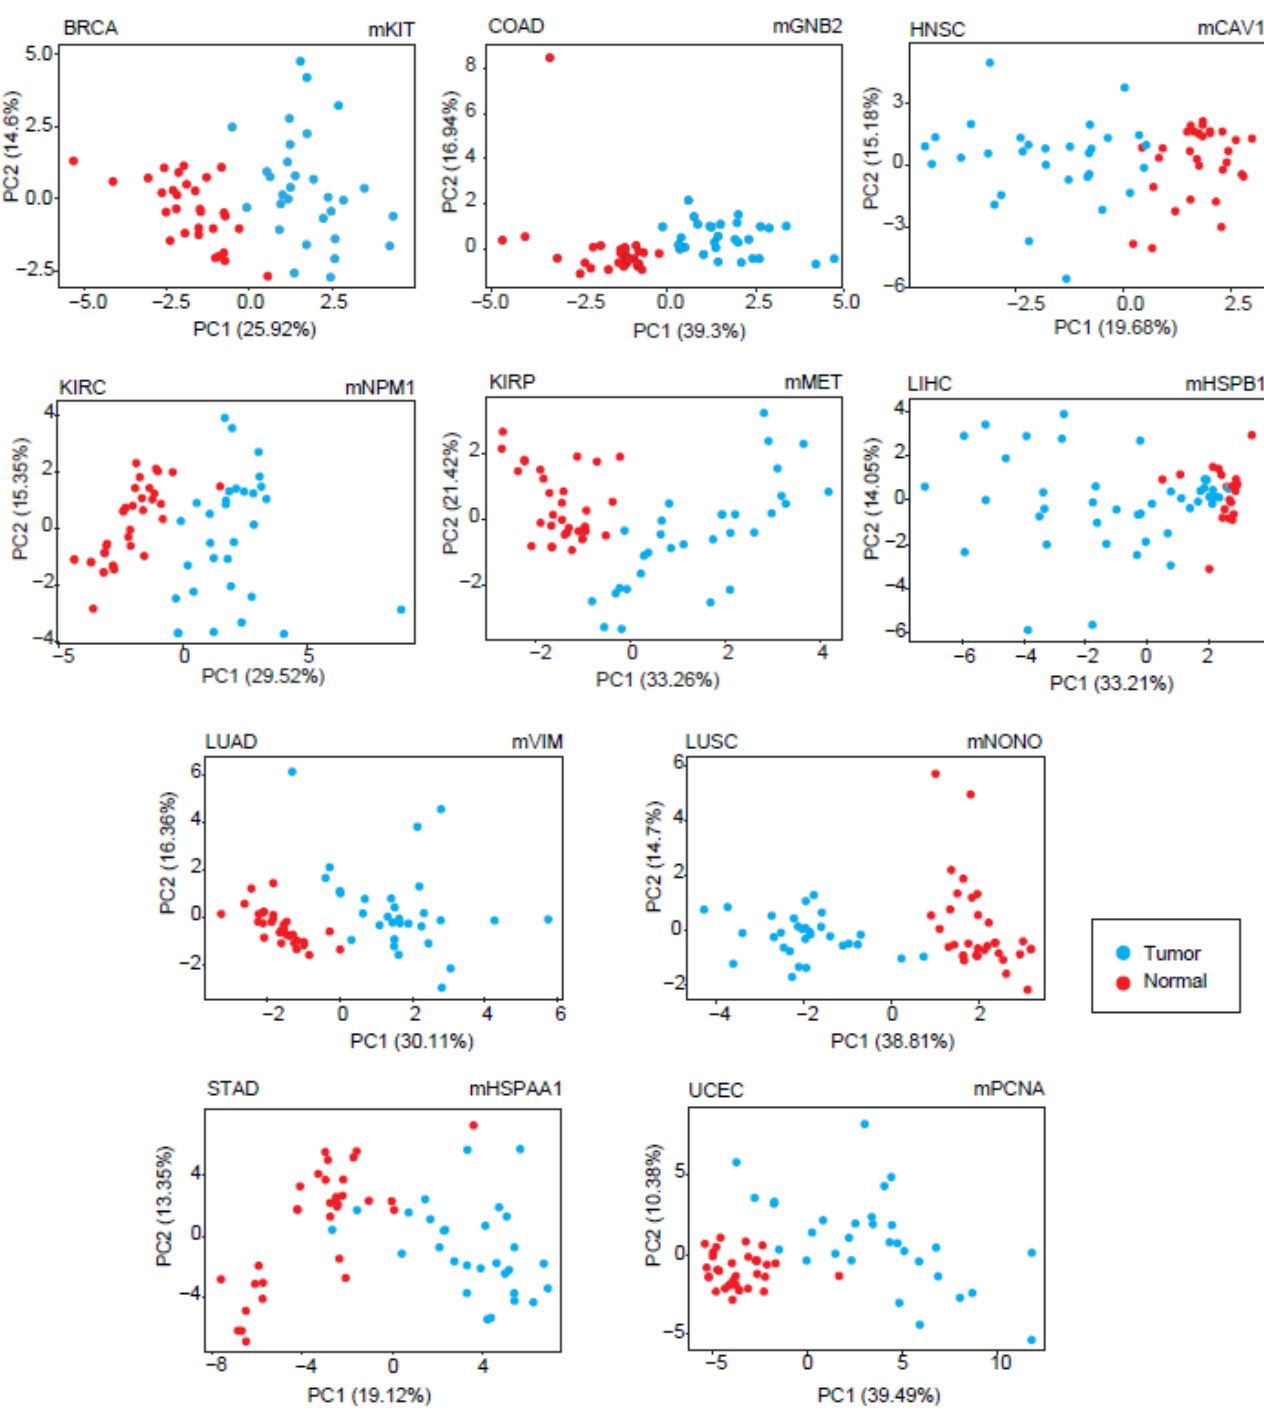
Figure 5. Principal component analyses for different cancer types. PCA plots showing individual differences in protein expression profiles between cancer types comprising at least 30 individuals in each type.